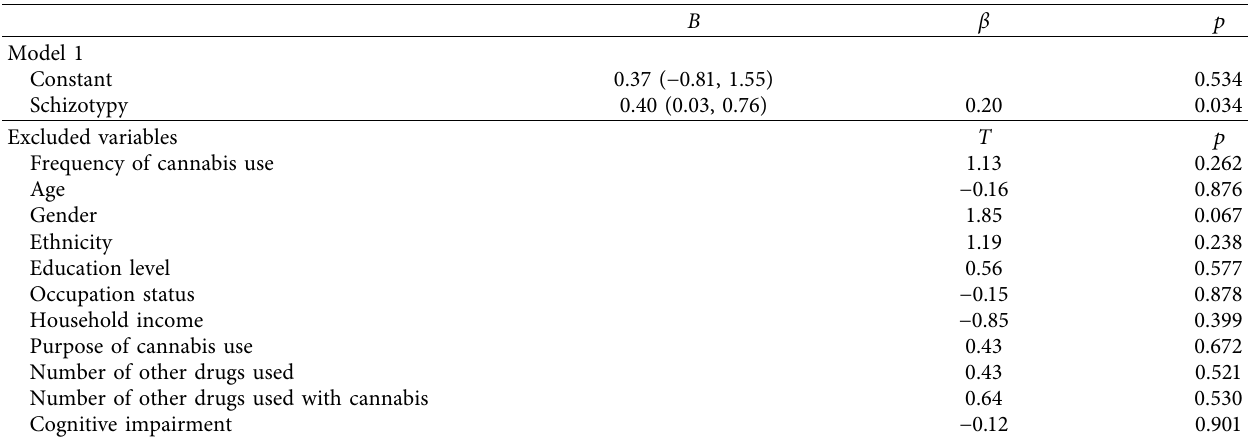
Table 3: Summary of the stepwise regression analysis for variables predicting unusual